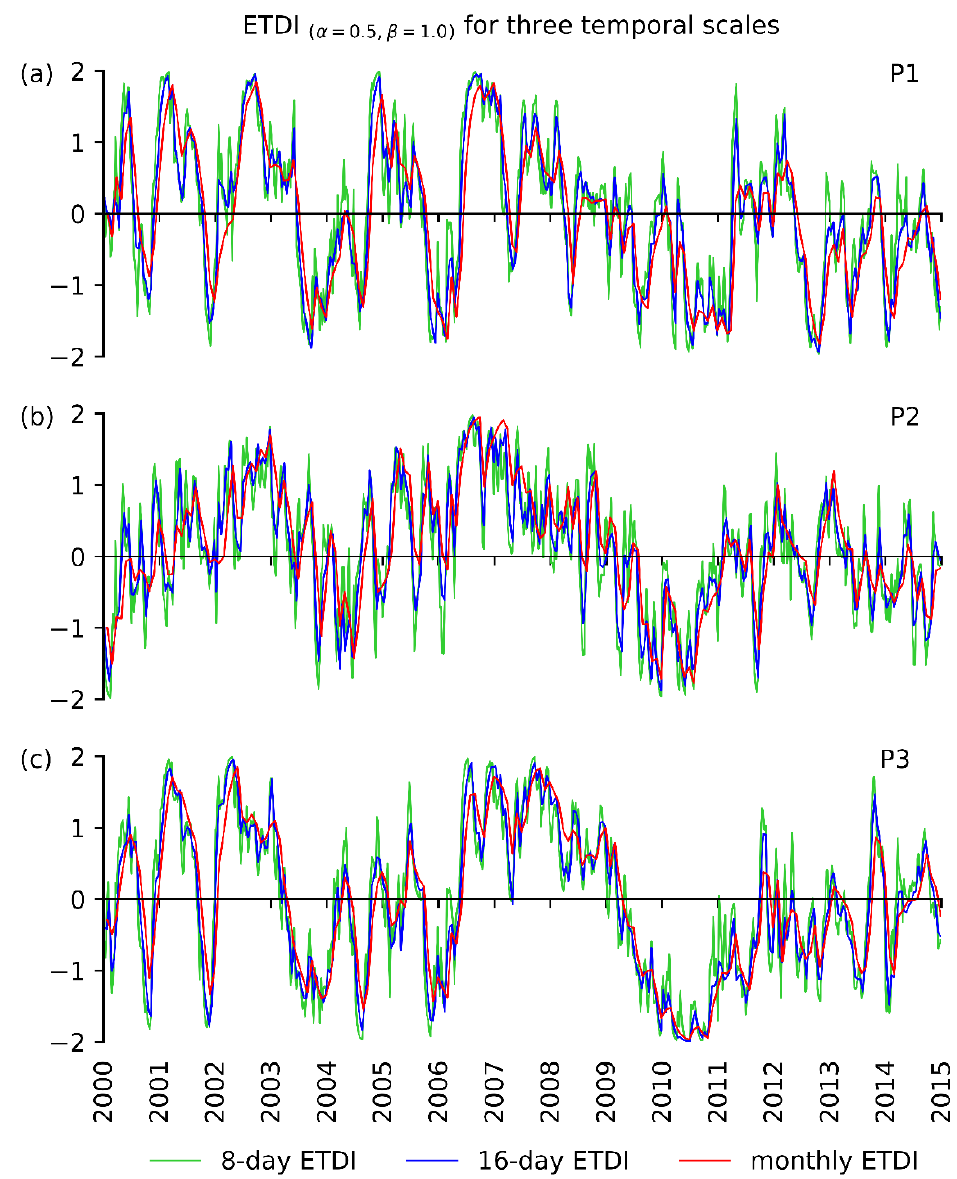
Figure 6. Evapotranspiration deficit index (ETDI) at 8-day, 16-day, and 1-month temporal scales at points P1 to P3 in the Ruvu River basin.